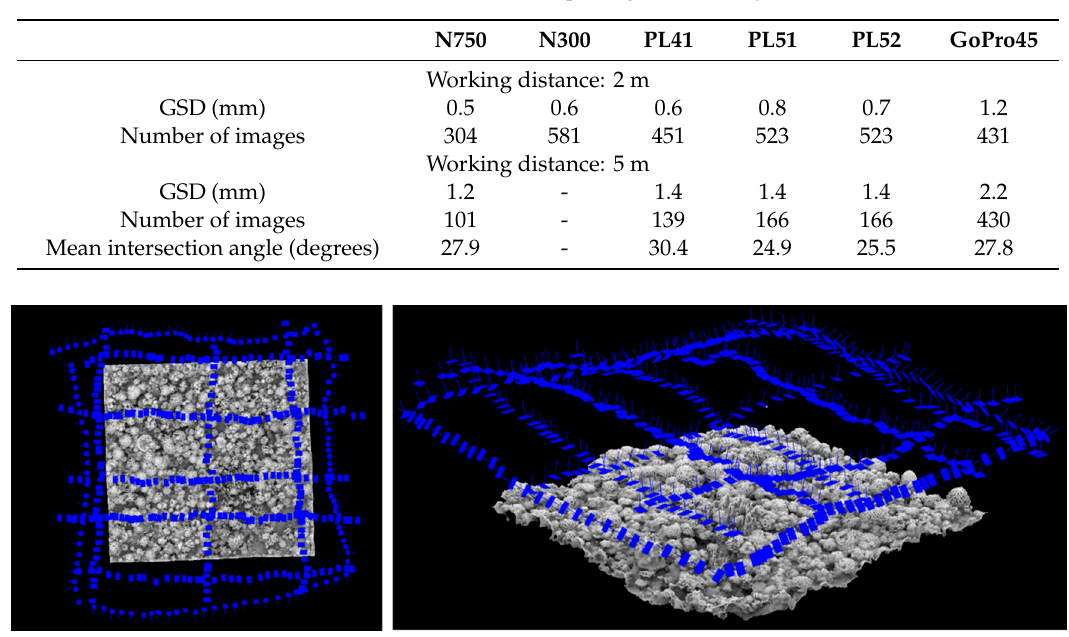
Figure 7. Top and birds-eye views of a typically implemented camera network with cross-strips and oblique images at 2 m working distance.